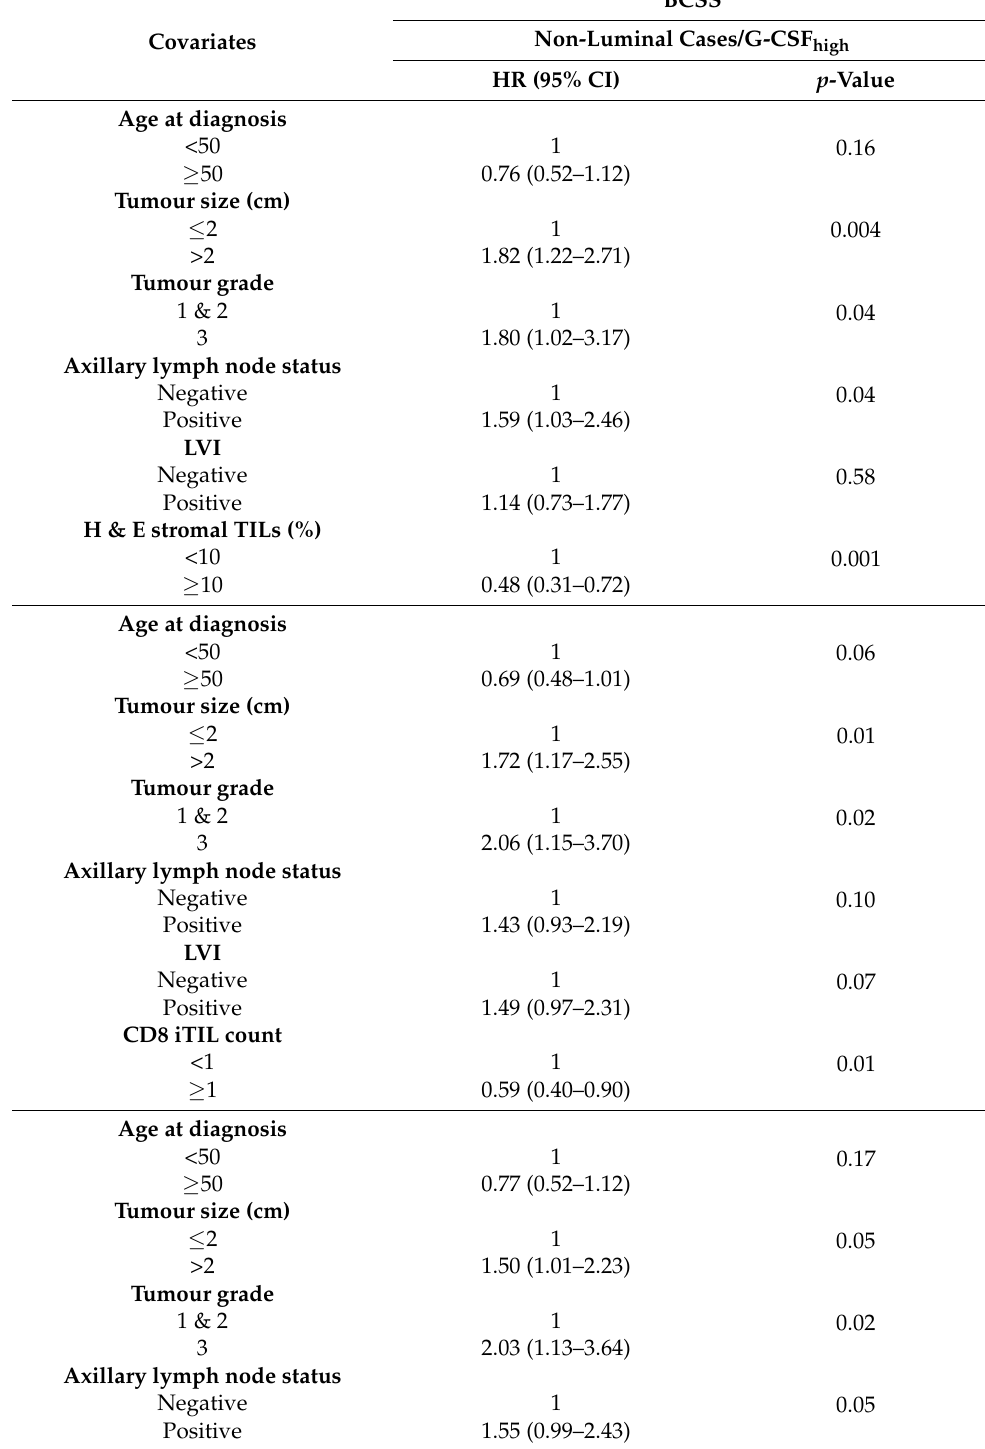
Table 3. Multivariable analysis for prognostic significance of immune biomarkers in non-luminal cases with G-CSF high